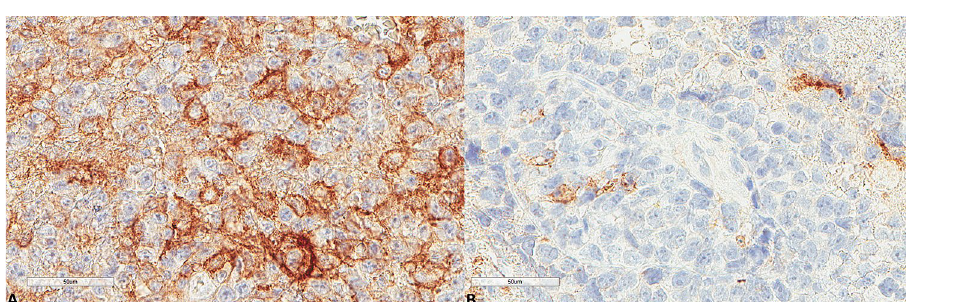
Figure 2. Representative images of PD-L1 expression. ( A ) Higher expression in a patient diagnosed with PCNSL MSKCC B group (× 400). ( B ) Lower expression in a patient diagnosed with PCNSL MSKCC C group (×